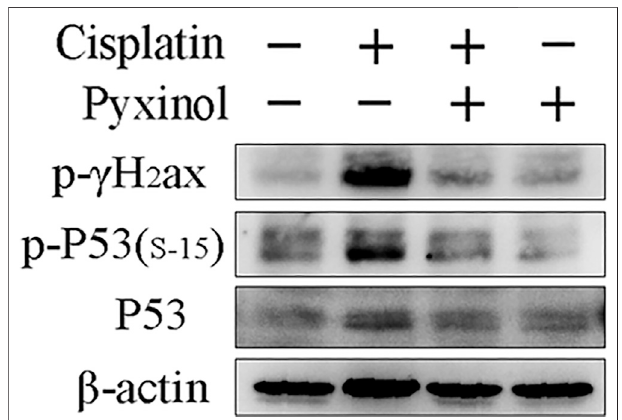
FIGURE 6 | Effects of pyxinol on the phosphorylation of P53 and γ H2ax induced by cisplatin in rats. Total protein expressions were detected using western blotting